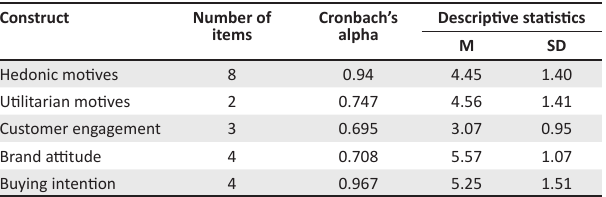
TABLE 4: Cronbach’s alpha values and descriptive statistics for the